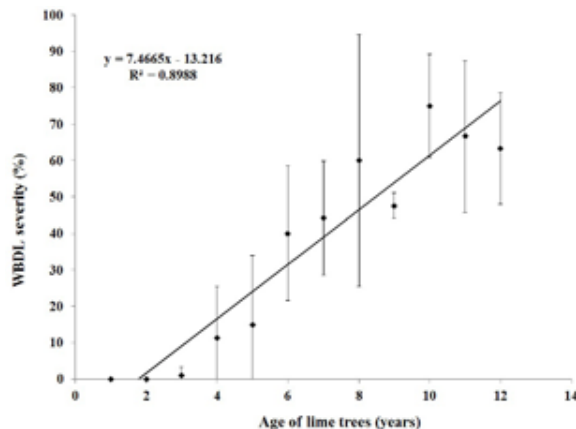
Figure 2. Development of witches’ broom symptoms in re- lation to age of acid lime trees. Disease severity represents the percentage of symptomatic branches in trees. The data are based on a survey of 73 farms and 6,926 acid lime trees, of age 1 to 12 years. Error bars indicate standard deviations.